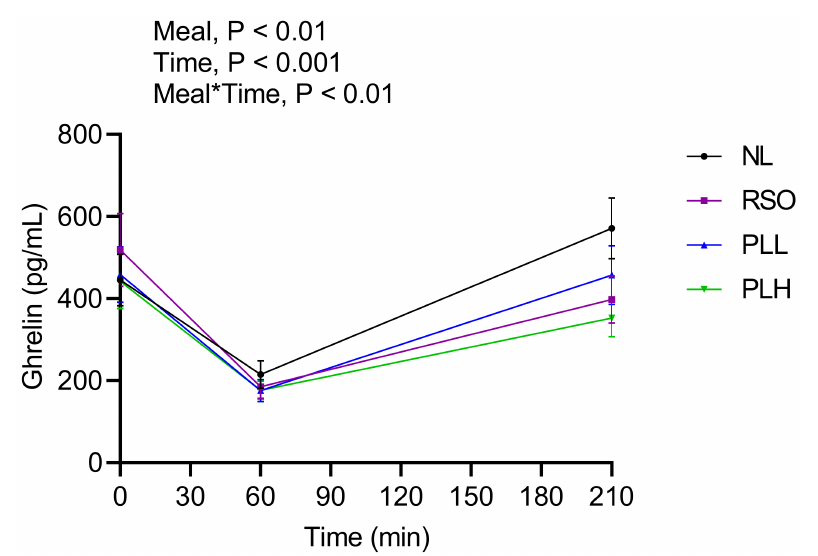
Figure 6. Mean concentrations of ghrelin after the breakfast meals. Values are means ± SEM, n = 20 healthy subjects. Repeated measures; mixed model in SAS. NL, oat preparation without added lipids; RSO, oat preparation added with rapeseed oil; PLL, oat preparation with a low concentration of polar lipids; PLH, oat preparation with a high concentration of polar